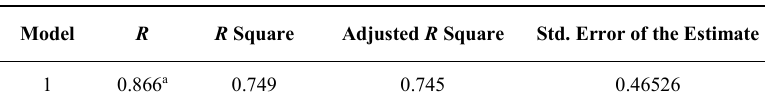
Table 4. Model Summary.